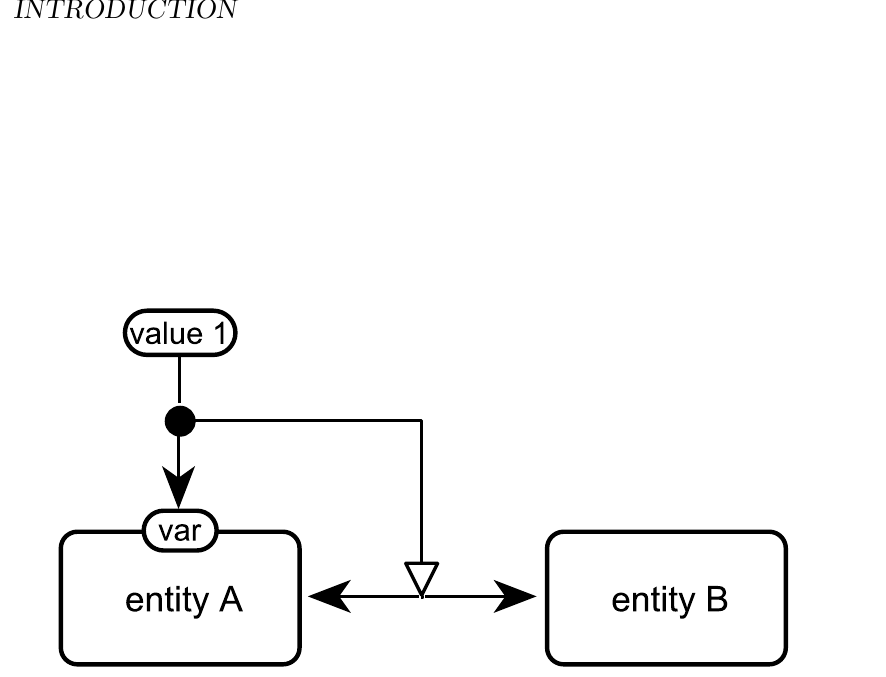
Figure 1.1: This example of an Entity Relationship map represents an entity A interacting with another entity B. The assignment of value 1 to the state variable var of the entity A stimulates the interaction between entity A and entity